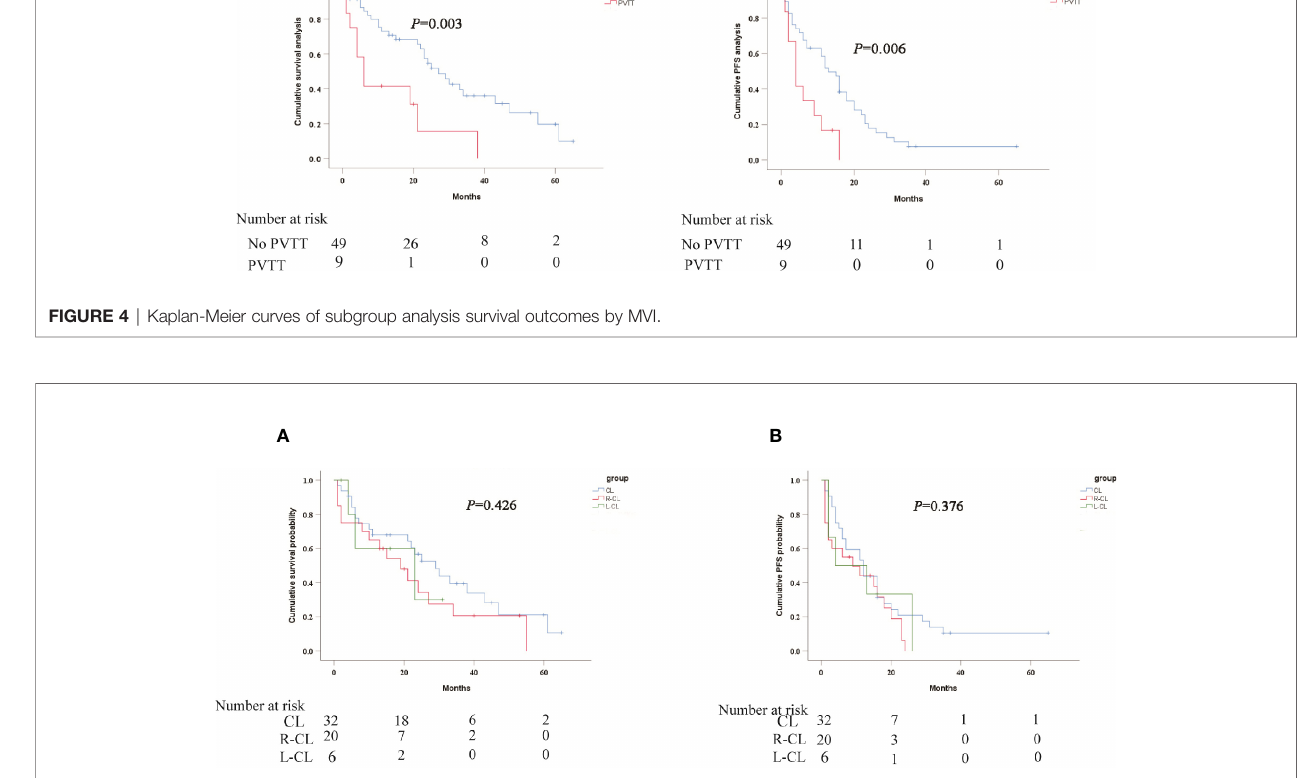
FIGURE 5 | Kaplan-Meier curves of subgroup analysis survival outcomes by tumor